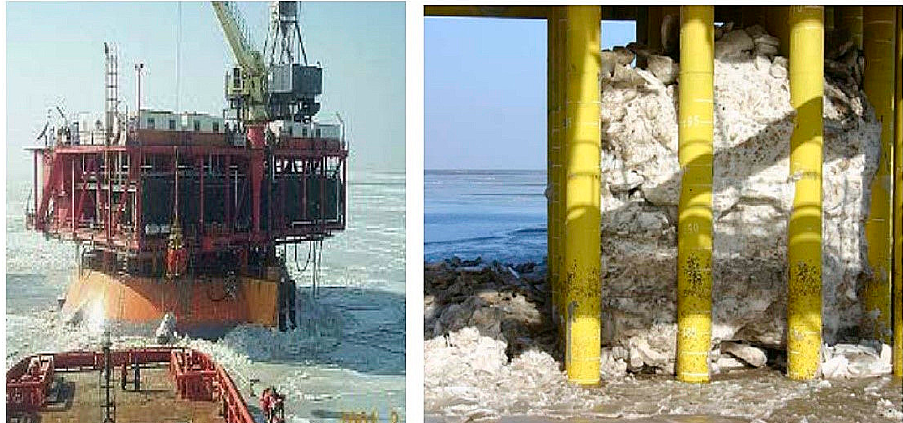
Figure 4. Offshore platforms with icy mode conditions [23].